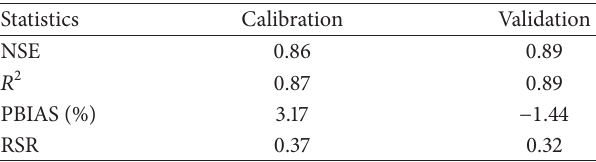
Table 4: Evaluation statistics of hydrological